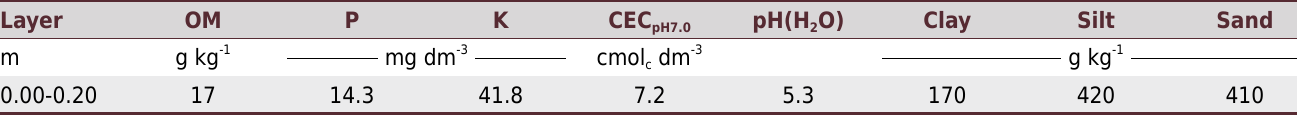
Table 1. Soil physicochemical characterization before the beginning of the experiment Layer OM P K CEC pH7.0 pH(H 2 O) Clay Silt Sand